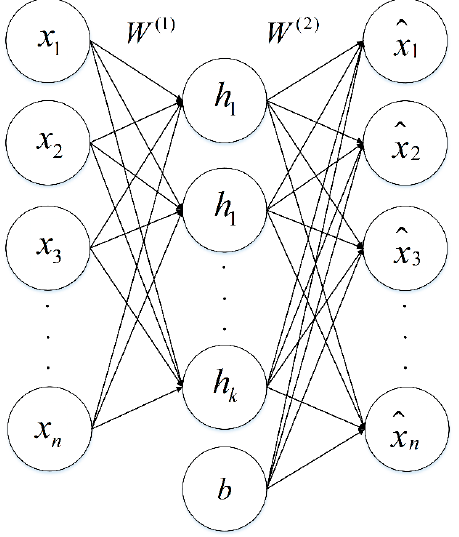
x i n  represents the input of autoencoder, Figure 1. Basic autoencoder model. , 1,..., i Figure 1. Basic autoencoder model. x i , i P 1, . . . , n represents the input of autoencoder, h j , j P 1, . . . , k is , the value of hidden units, ˆ x i , i P 1, . . . , n is the approximate output, W p i q , i P 1,2 denotes the weight matrix, b is the bias denotes the weight matrix, b is the bias term.